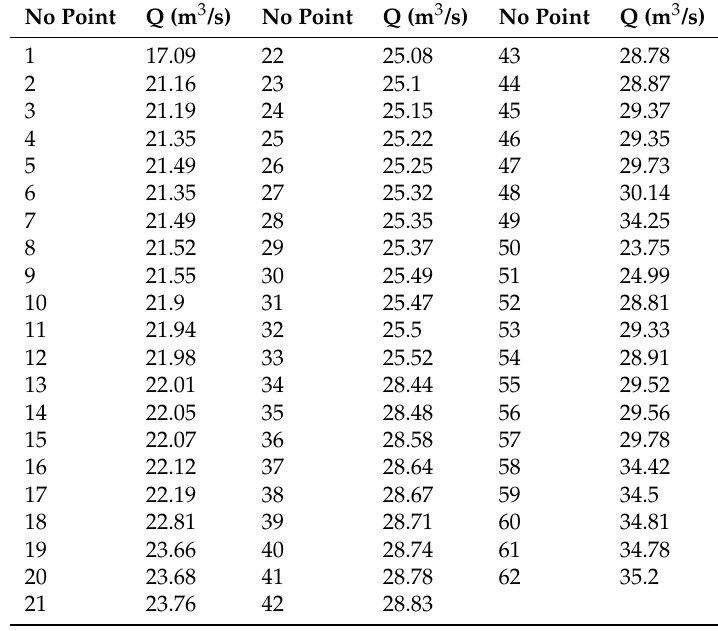
Figure 6. ( A ) Identification of points along the studied reach of Topino River (from Google Hybrid). ( B ) Visualization of the Umbrian region overlapped by the Topino River main channel. Table 1. Values for the peak flow discharge corresponding to the 62 cross-sections along the Topino